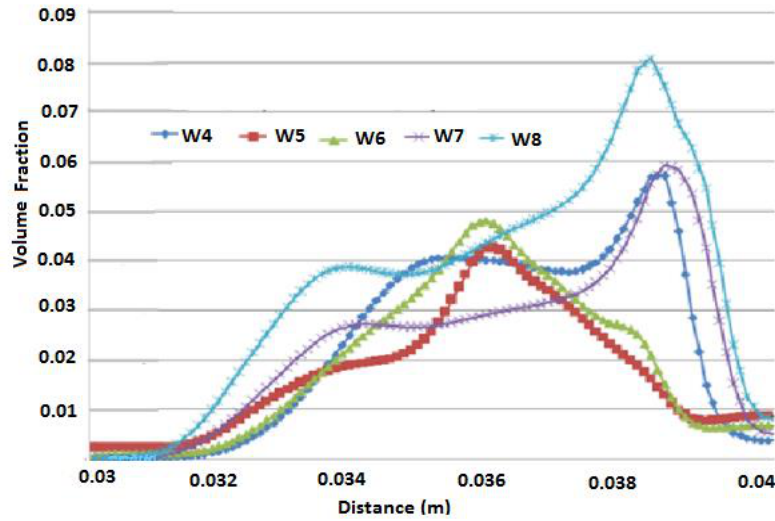
Figure 8. Variation of solid phase volume fraction for particle sizes along plane 4